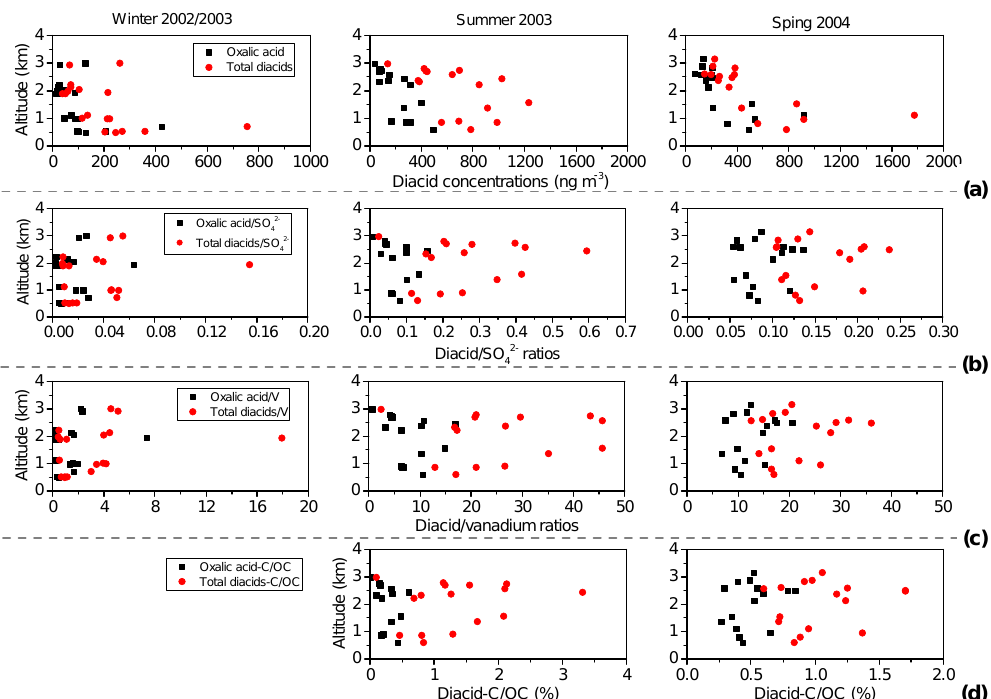
Figure 6. Vertical profiles of (a) concentrations of oxalic acid and total diacids, and their relative abundance to (b) sulfate (SO 2 − dium (V) and (d) organic carbon (OC, %) in aerosol samples collected during winter 2002 (left), summer 2003 (middle) and spring 2004 (right) aircraft campaigns over